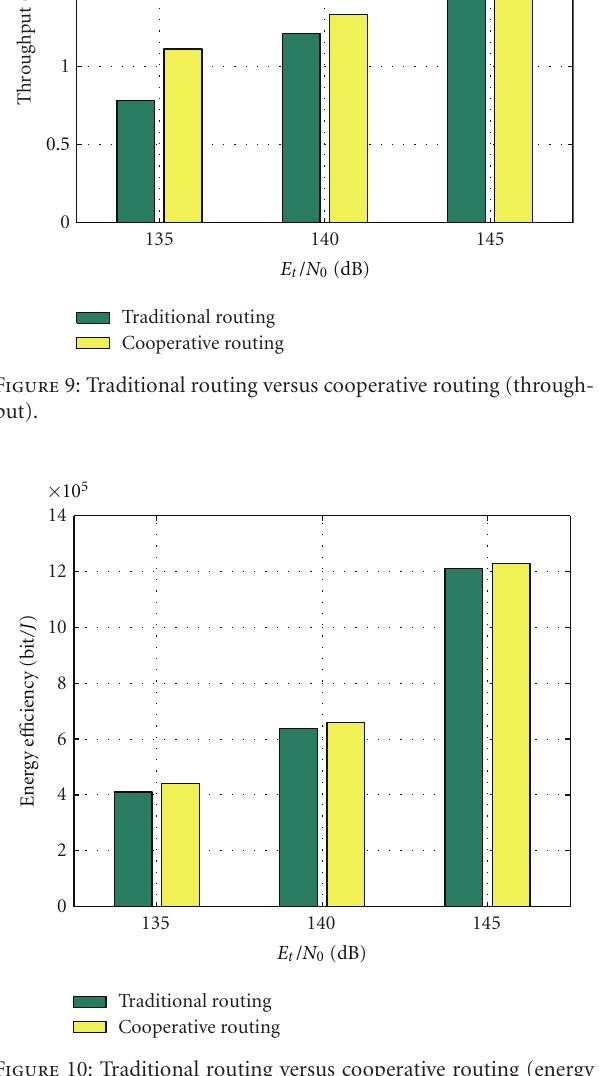
Figure 10: Traditional routing versus cooperative routing (energy e ffi ciency).